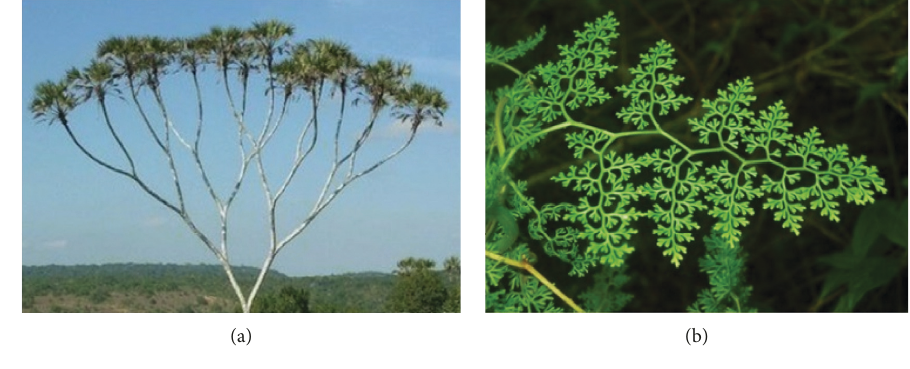
Figure 1: Binary branches in